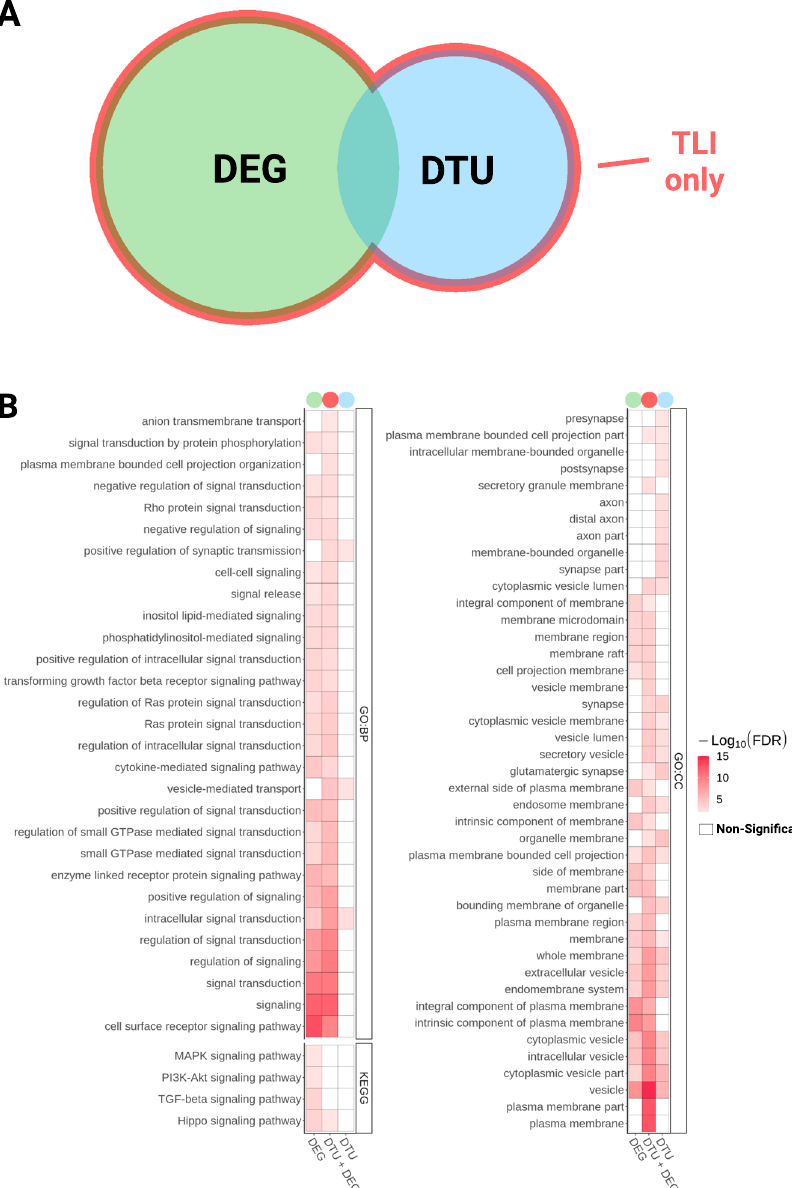
Fig. 4 Differential transcript usage analysis in AD brains reveals gene expression alterations overlooked in DEG analysis. A Venn diagram showing DEGs and gDTUs identi fi ed in the TLI. B Comparison of GO and KEGG terms enriched for DEG, gDTU, or DEG + gDTU identi fi ed in the